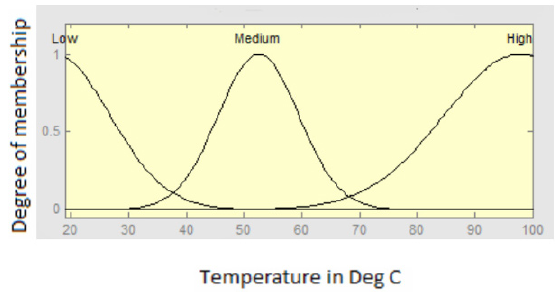
Figure 4. Membership function of temperature as input variable.